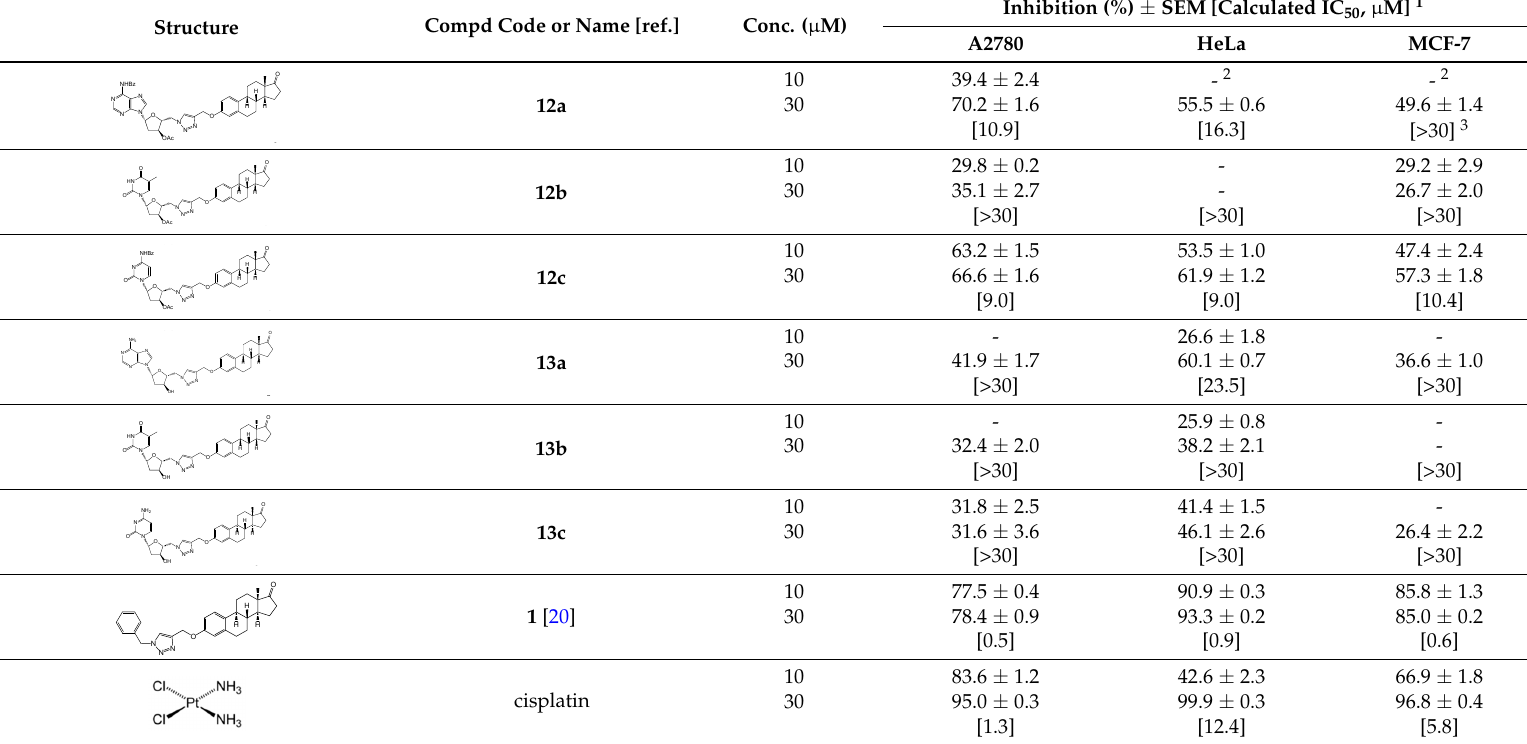
Table 2. Antiproliferative properties of the synthesized compounds. Mean value from two independent determinations with five parallel wells; standard deviation